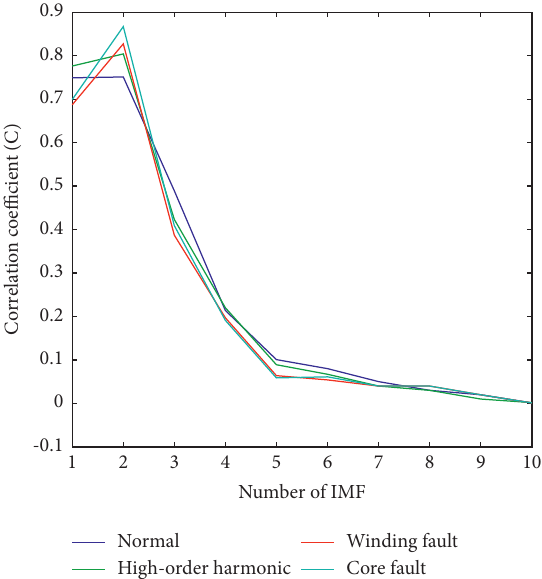
Figure 9: Average value of correlation